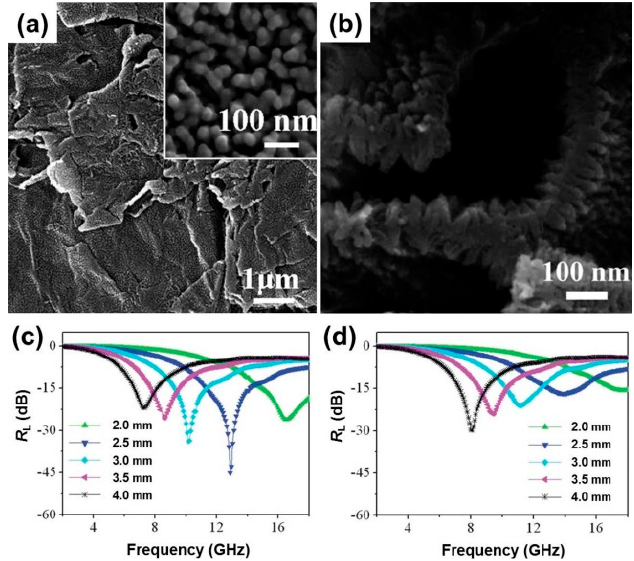
Figure 12. SEM images of graphene/PANI nanorod arrays. ( a ) Top-view, inset: magnified SEM image, and ( b ) the side-view. The reflection loss calculated for ( c ) the graphene/PANI nanorod arrays and ( d ) the PANI nanorods with thicknesses of 2–4 mm. Reprinted with permission from Reference [140].